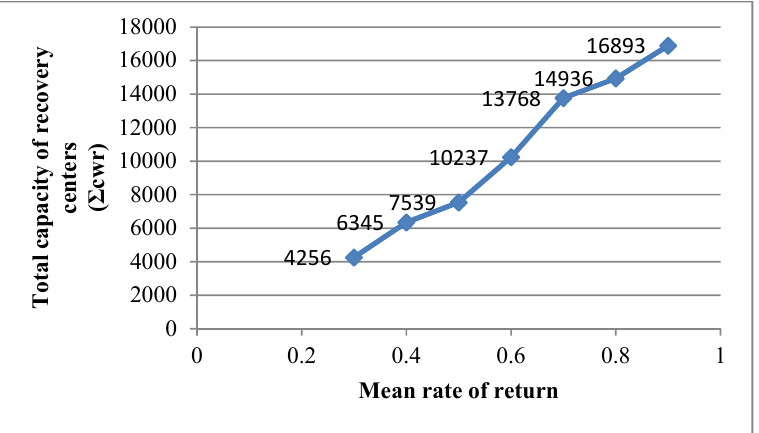
Fig. 3. Total capacity of recovery centers vs. mean rate of